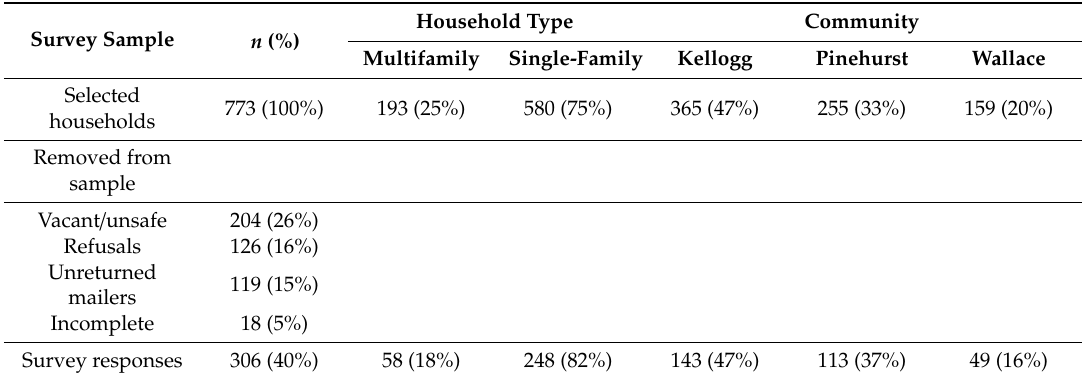
Table 1. Drop-o ff , pick-up survey